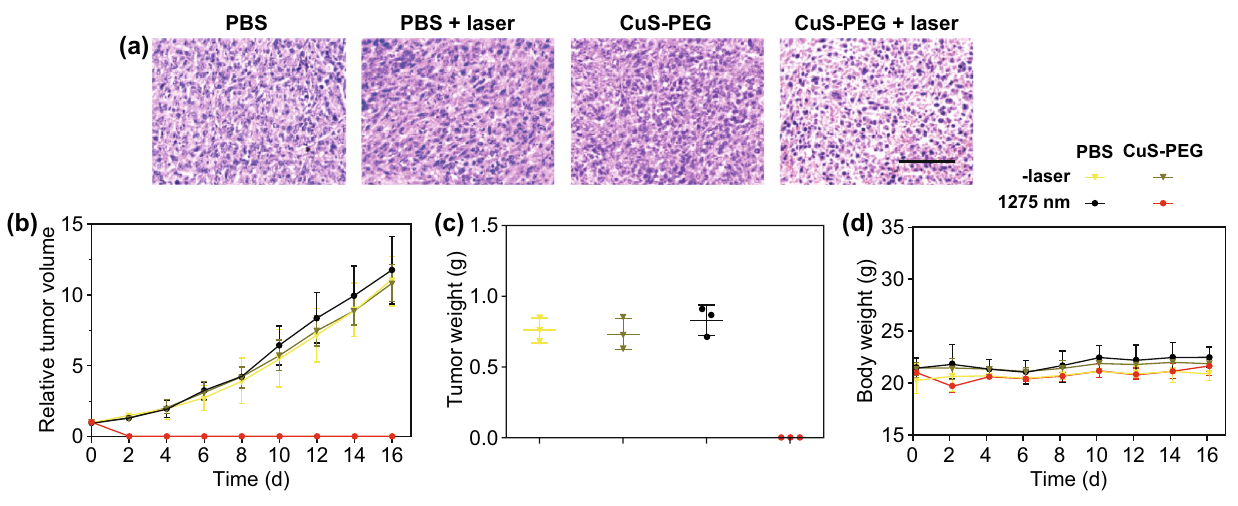
Fig. 7 Histological analysis and records of tumor volume and mice weight. a H&E stained results of tumor sections that were collected from mice of different treatments. The scale bar is 100 μm. b Tumor growth data of different groups of mice after different treatments. c Weights of tumors in mice sacrificed after 16-day observation. d Body weight data of different groups of mice after treatments. The error bars represent standard deviations ( n = 3 per